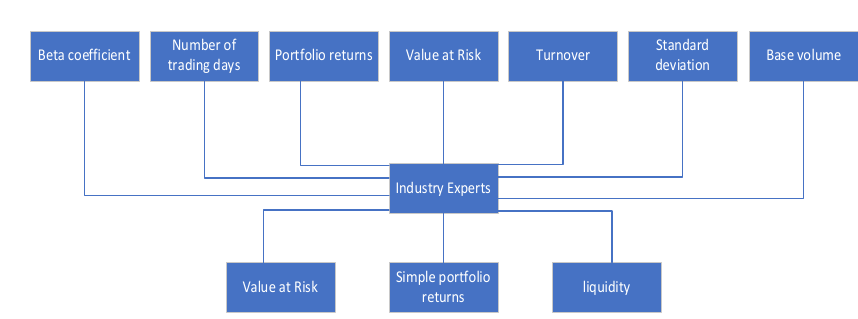
Figure4. Diagram of the process of selecting